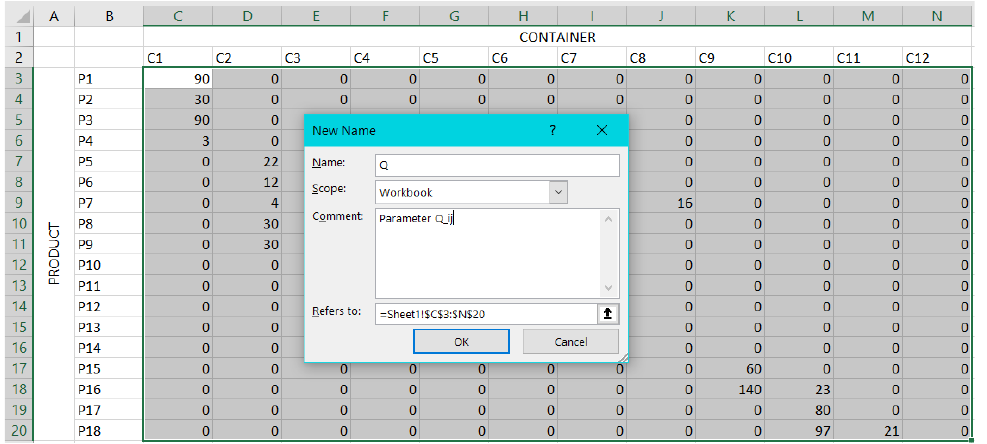
Figure 1. Defining parameter Q Range name in the worksheet.